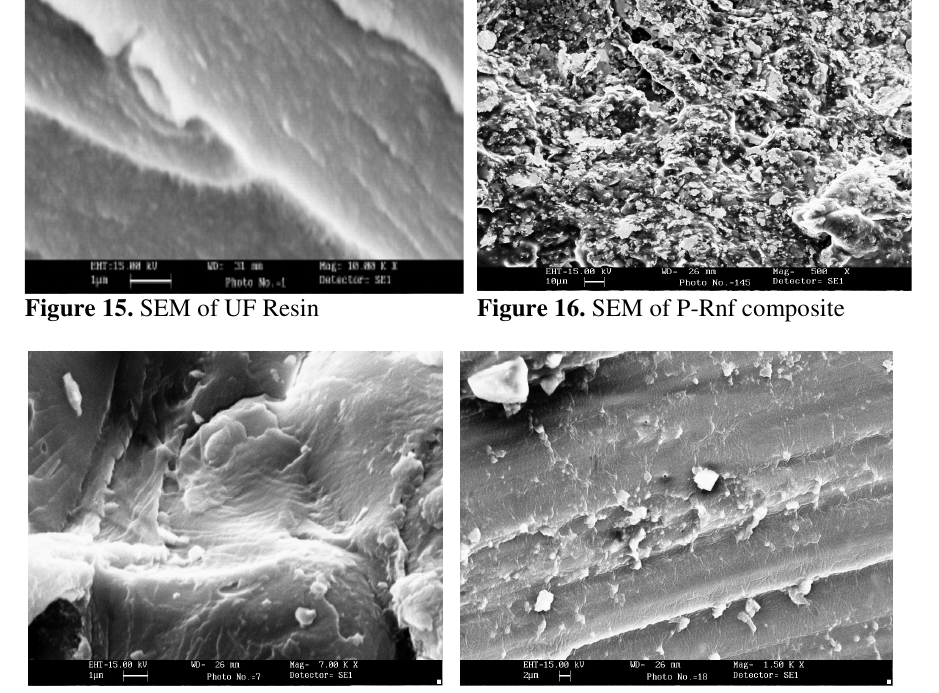
Figure 17. SEM of SF-Rnf composite Figure 18. SEM of SF-Rnf